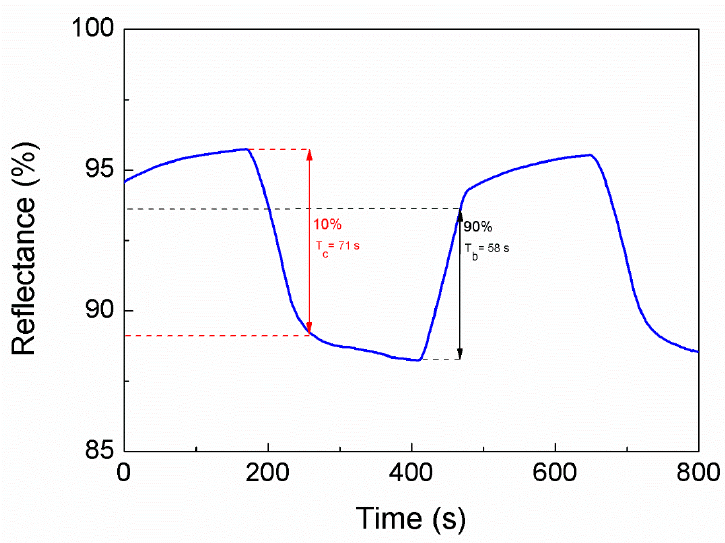
Figure 7. Lifetime cycles measurements for the TiO 2 nanostructured films synthesized using nitric acid, for applied voltages of − 5 and 5 V (hold time of 240 s), with an exposed area of 1 cm 2 at 550 nm.